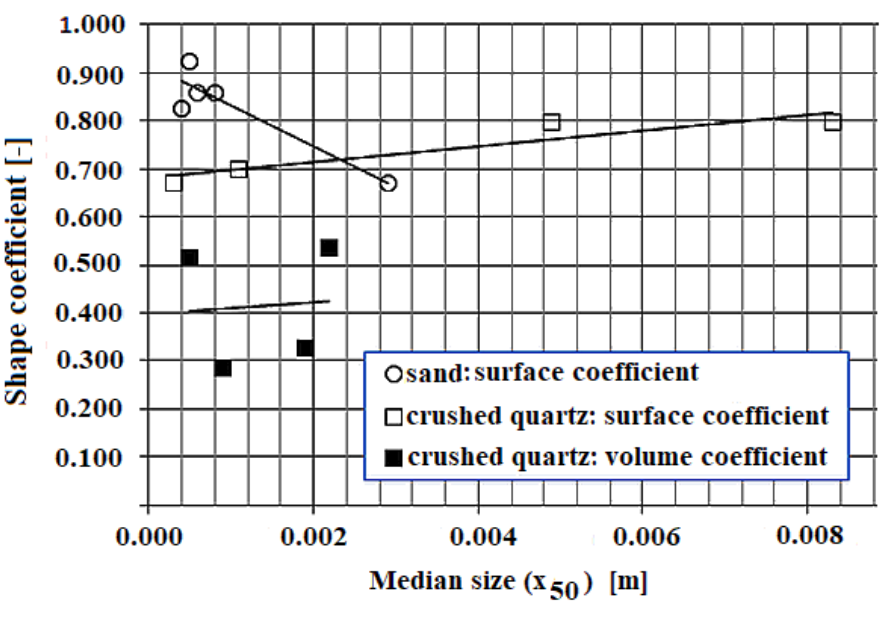
Figure 1. Variation of shape coefficients as a function of particle size and provenance (data from Table